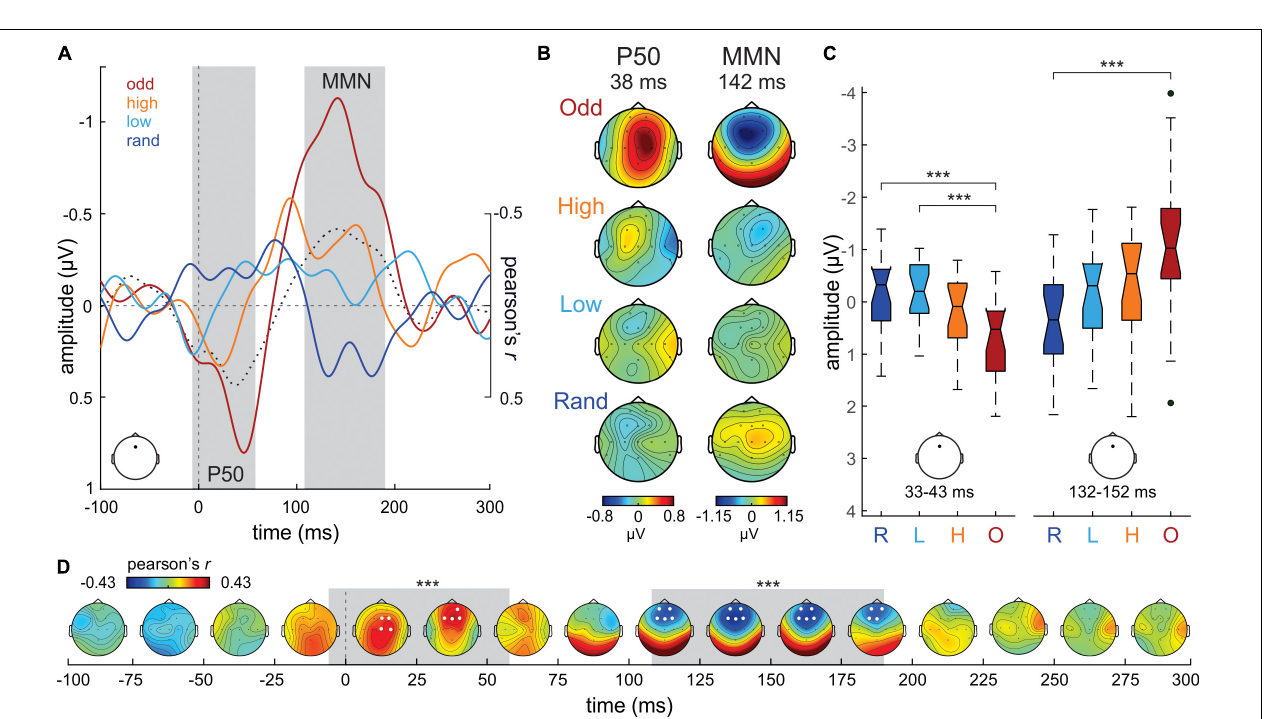
FIGURE 2 | (A) ERP waveforms from Fz electrode evoked to S stimuli in the Oddball (odd; dark red), High confidence (high; orange), Low confidence (low; cyan) and Random (rand; dark blue) conditions. Correlation values (Pearson’s r) between S tone probability and S tone ERP amplitudes at each time point are plotted in a dotted black line. (B) P50, N1, and P2 scalp potential distribution maps per condition separately.